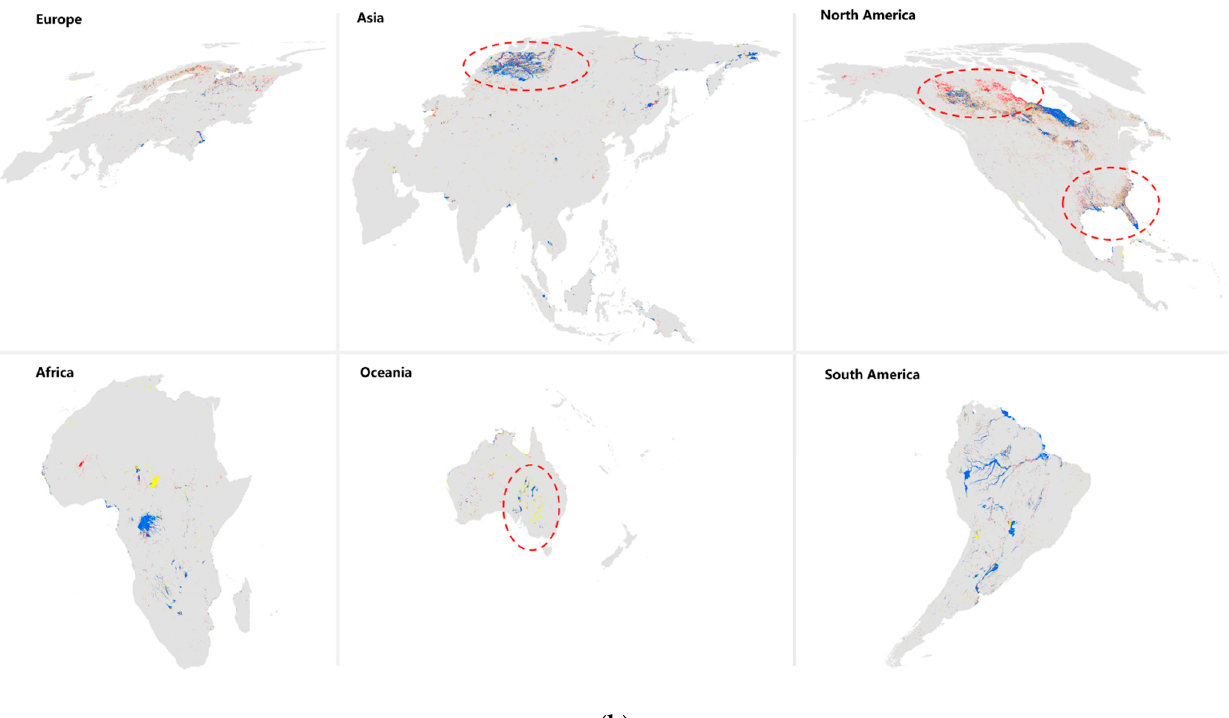
Figure 3. Changes in global wetlands from 2000 to 2020. ( a ). Changes in global spatial distribution of wetlands from 2000 to 2020. ( b ). Changes in global spatial distribution of wetlands from 2000 to 2020, by continent.